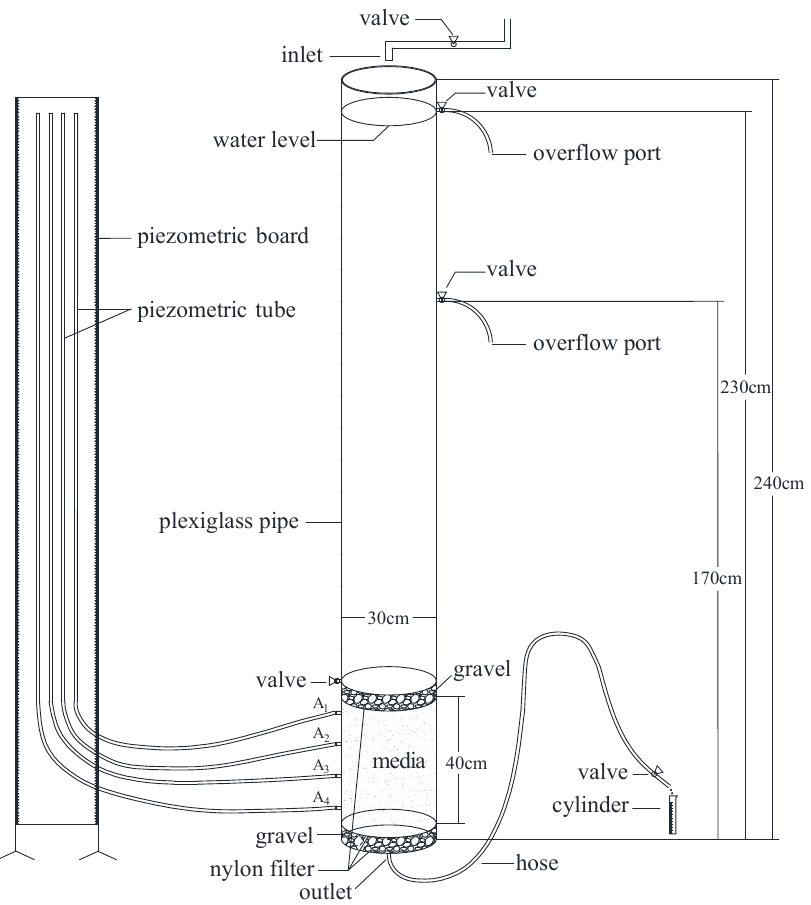
Figure 1. Schematic diagram of experimental setup used in this study.